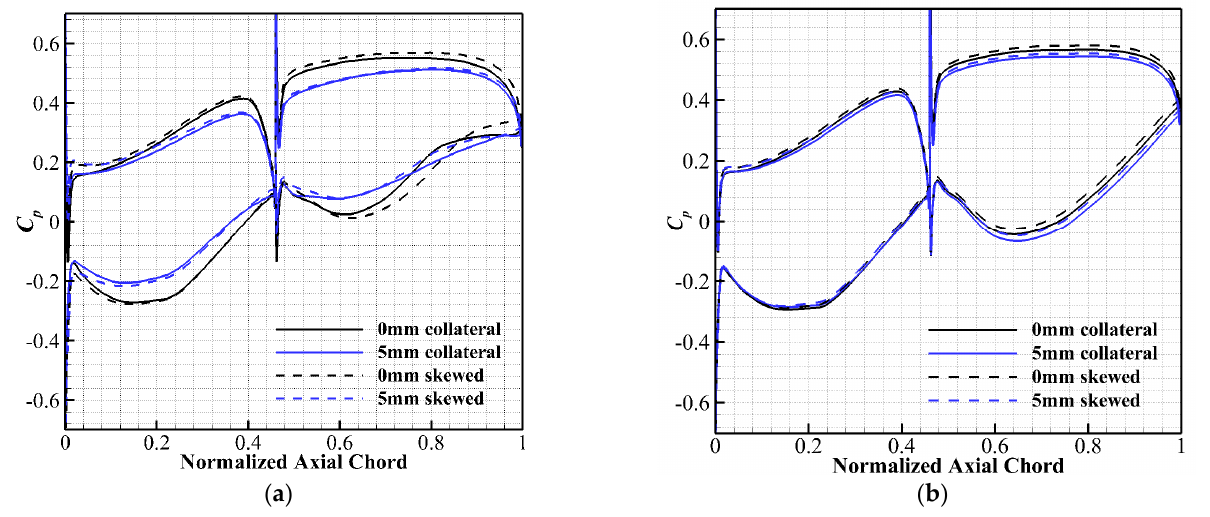
Figure 14. The C p distributions of the blade surface along the normalized axial chord of the tandem cascade at 5% h and 50% h : ( a ) 5% h ; ( b ) 50% h .